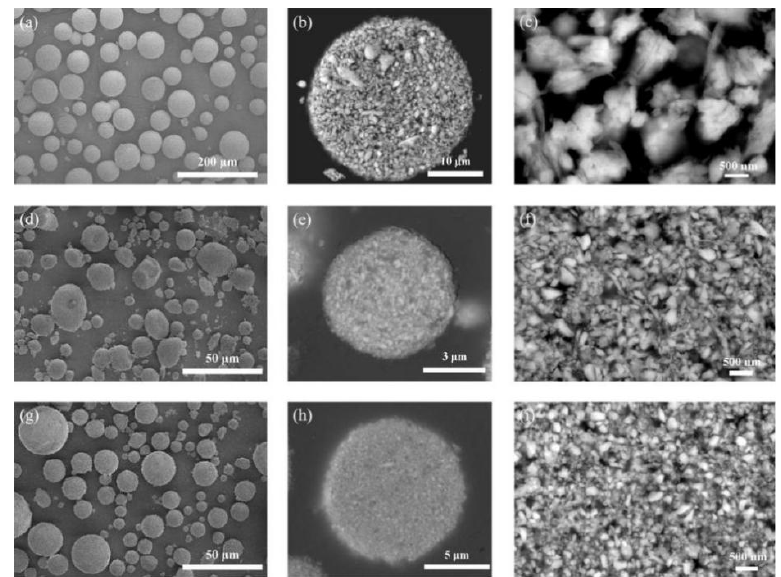
Figure 1. Morphologies of LC feedstocks: Powder 1: ( a ) surface, ( b ) cross-sectional, ( c ) magnified cross-sectional; Powder 2: ( d ) surface, ( e ) cross-sectional, ( f ) magnified cross-sectional; Powder 3: ( g ) surface, ( h ) cross-sectional, ( i ) magnified cross-sectional.